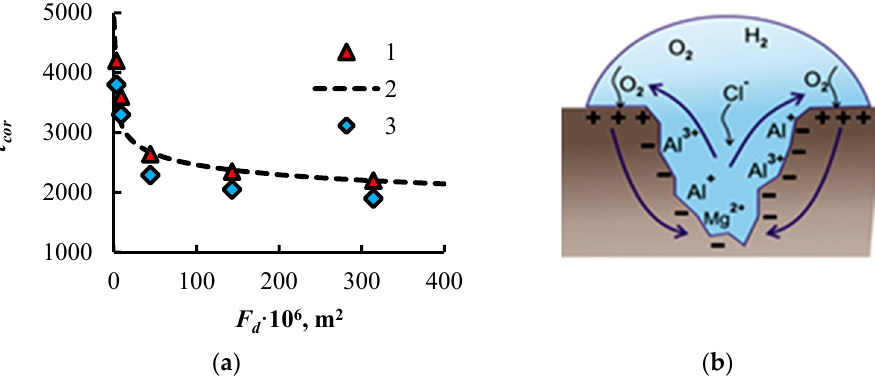
Figure 3. ( a ) The dependence of the conditional corrosion time τ cor on the droplet-wetted area F d ( τ cor ) corresponds to the time at which the entire surface became black (Figure 2): 1—the experimental data (the wall temperature T w =25 °C); 2—the curve constructed from Equation (3), T w =25 °C; 3—the experimental data ( T w =41 °C). ( b ) Scheme of the potential difference between the cathode (wall surface) and the anode (pit).